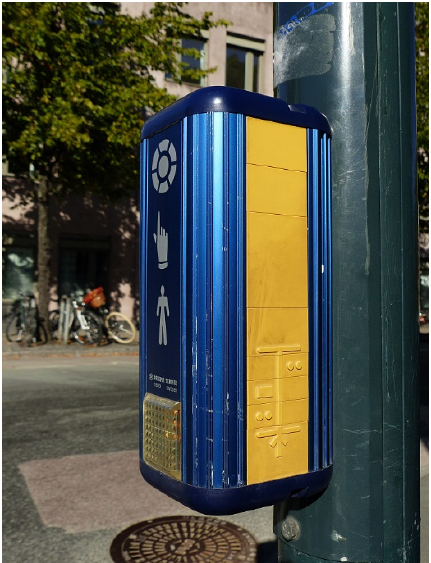
Figure 2. A simple tactile map by a pedestrian crossing in the city of Trondheim (source: authors). There are two basic methods of tactile map creation—either manual or